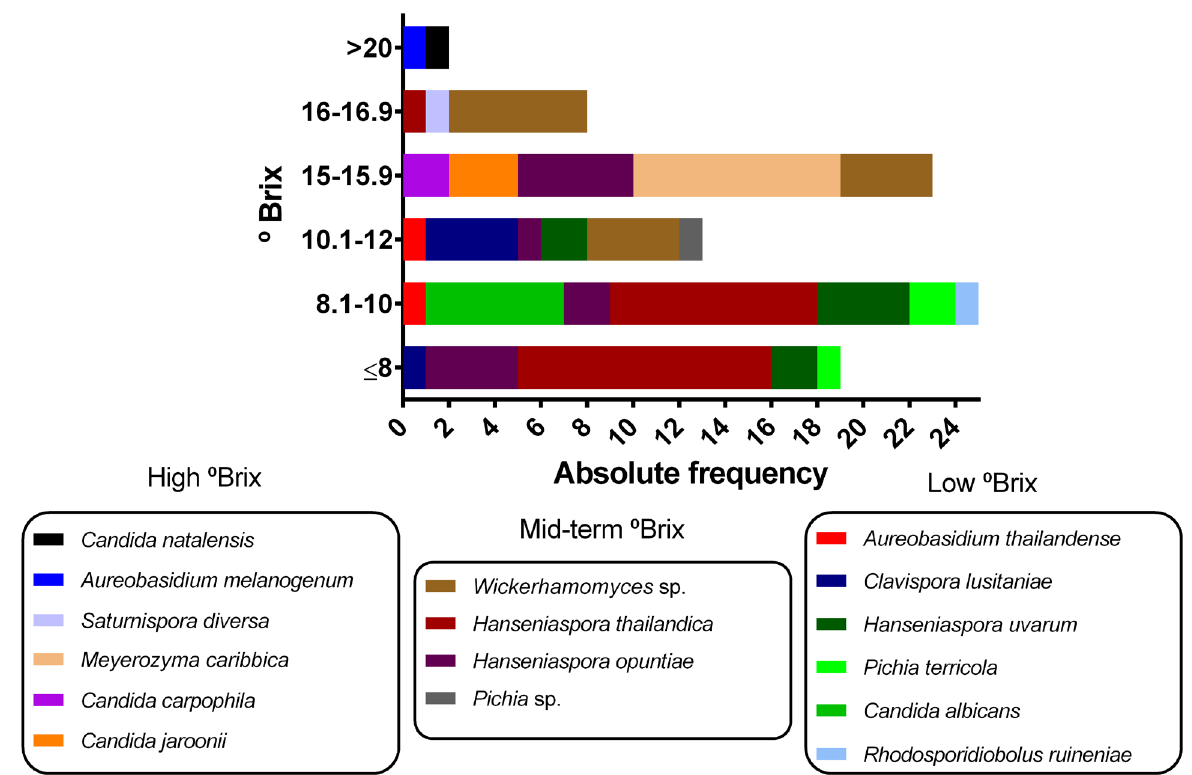
Figure 2 - Absolute frequency of yeast species found in mango and rose apple, classified according to ºBrix for each